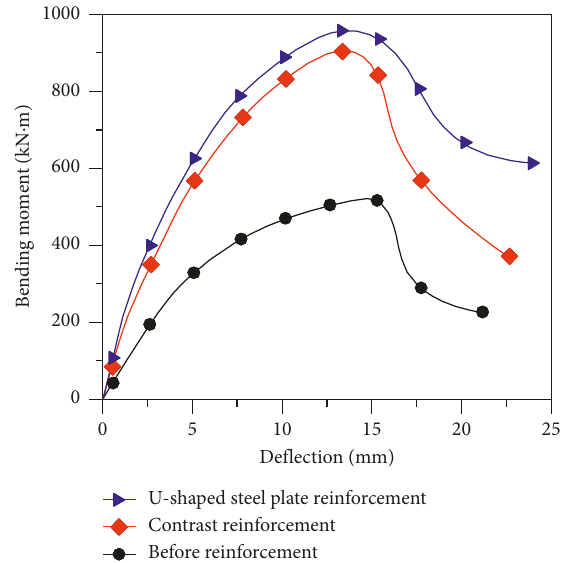
Figure 10: Bending moment-deflection